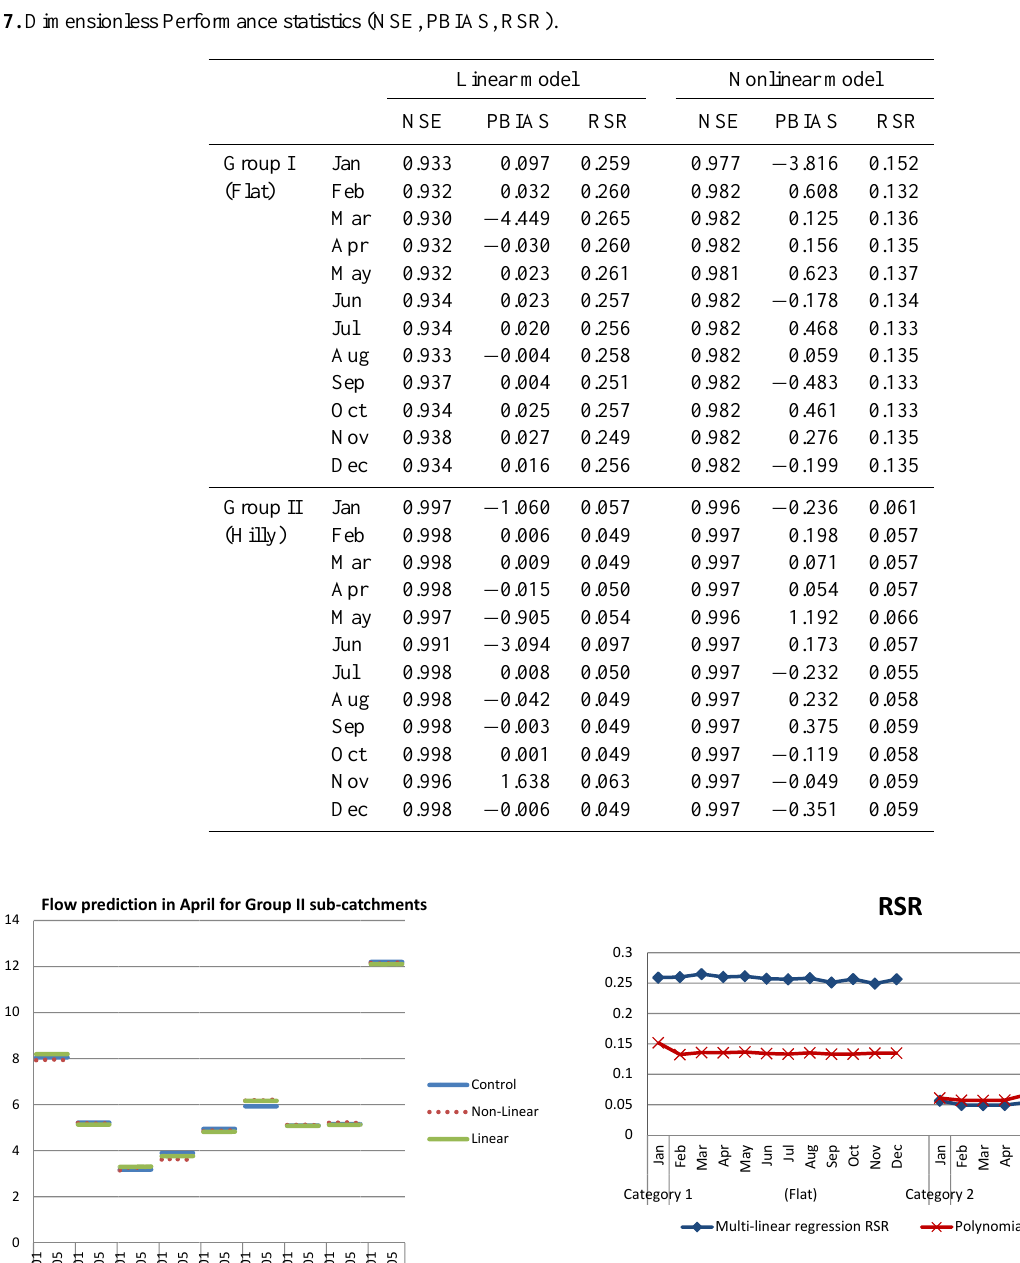
Fig. 9. RSR Performance Figure 9 RSR Performance statistics